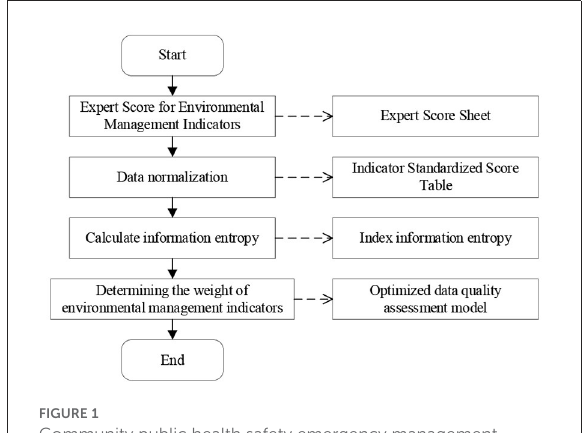
FIGURE1 Community public health safety emergency management evaluation process.